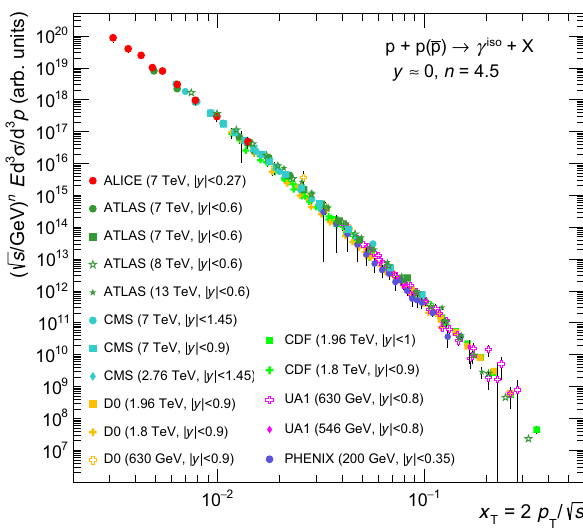
Fig. 10 ALICE data compared to the world’s data of isolated photon spectra measured in pp and pp collisions as a function of x T where √ s ) n with n = 4 . the invariant cross sections have been scaled by (